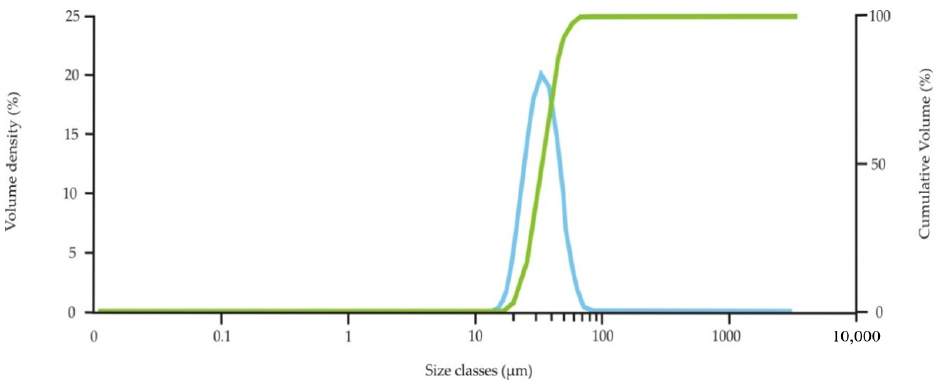
Figure 5. Scanning electron microscopy (SEM) in back-scattered electron (BSE) mode micrographs of